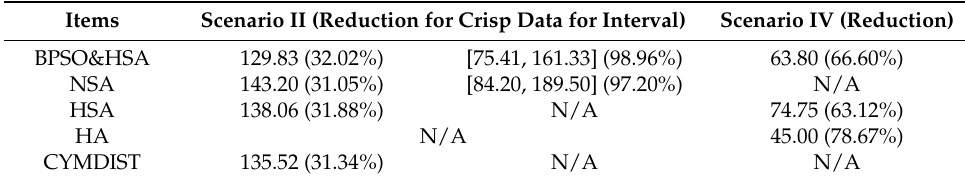
Table 3. The comparison of different methods in Scenarios II and